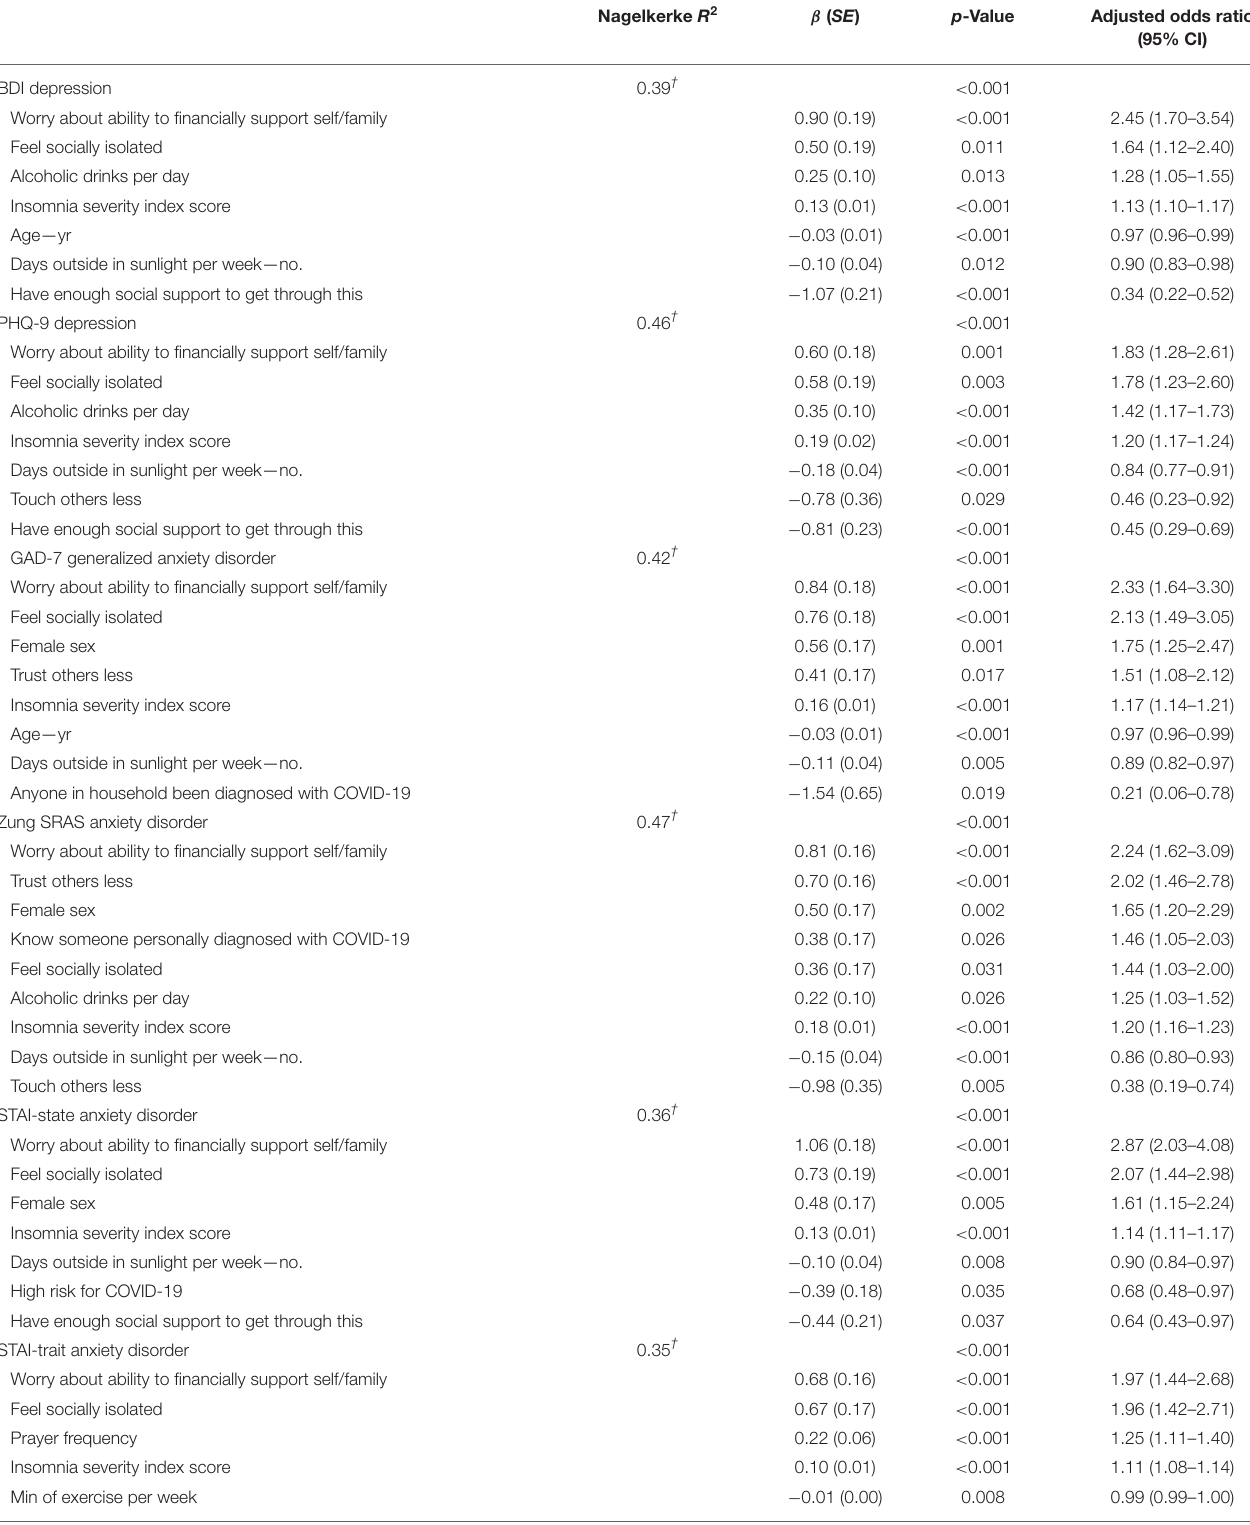
TABLE 3 | Factors contributing to total sample mental health outcomes based on binomial logistic